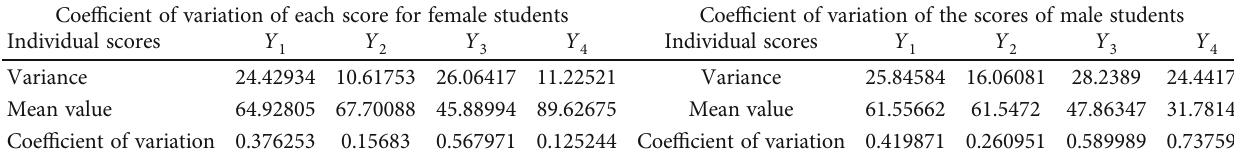
Table 5: The variance, mean, and coe ffi cient of variation of each score for male and female students. Coe ffi cient of variation of each score for female